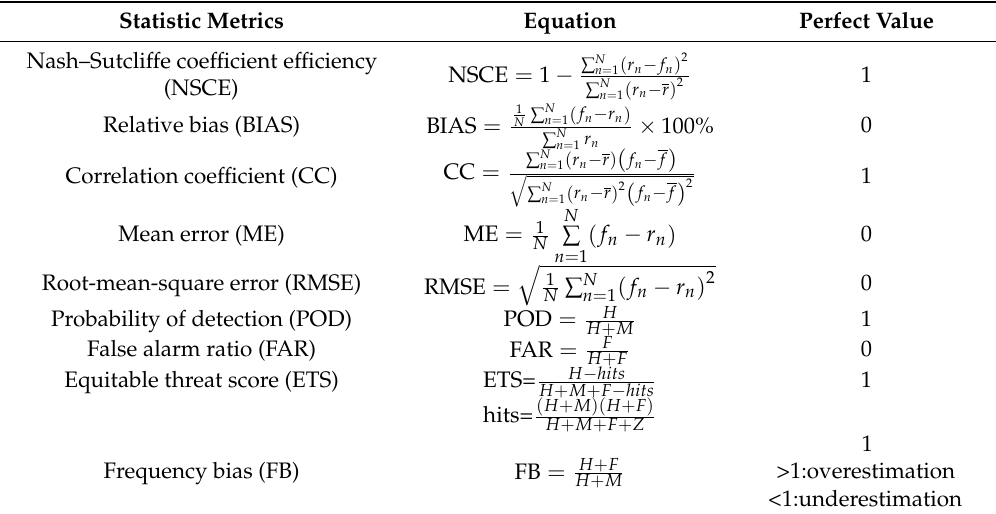
Table 2. List of the statistical metrics used in the comparison and evaluation.